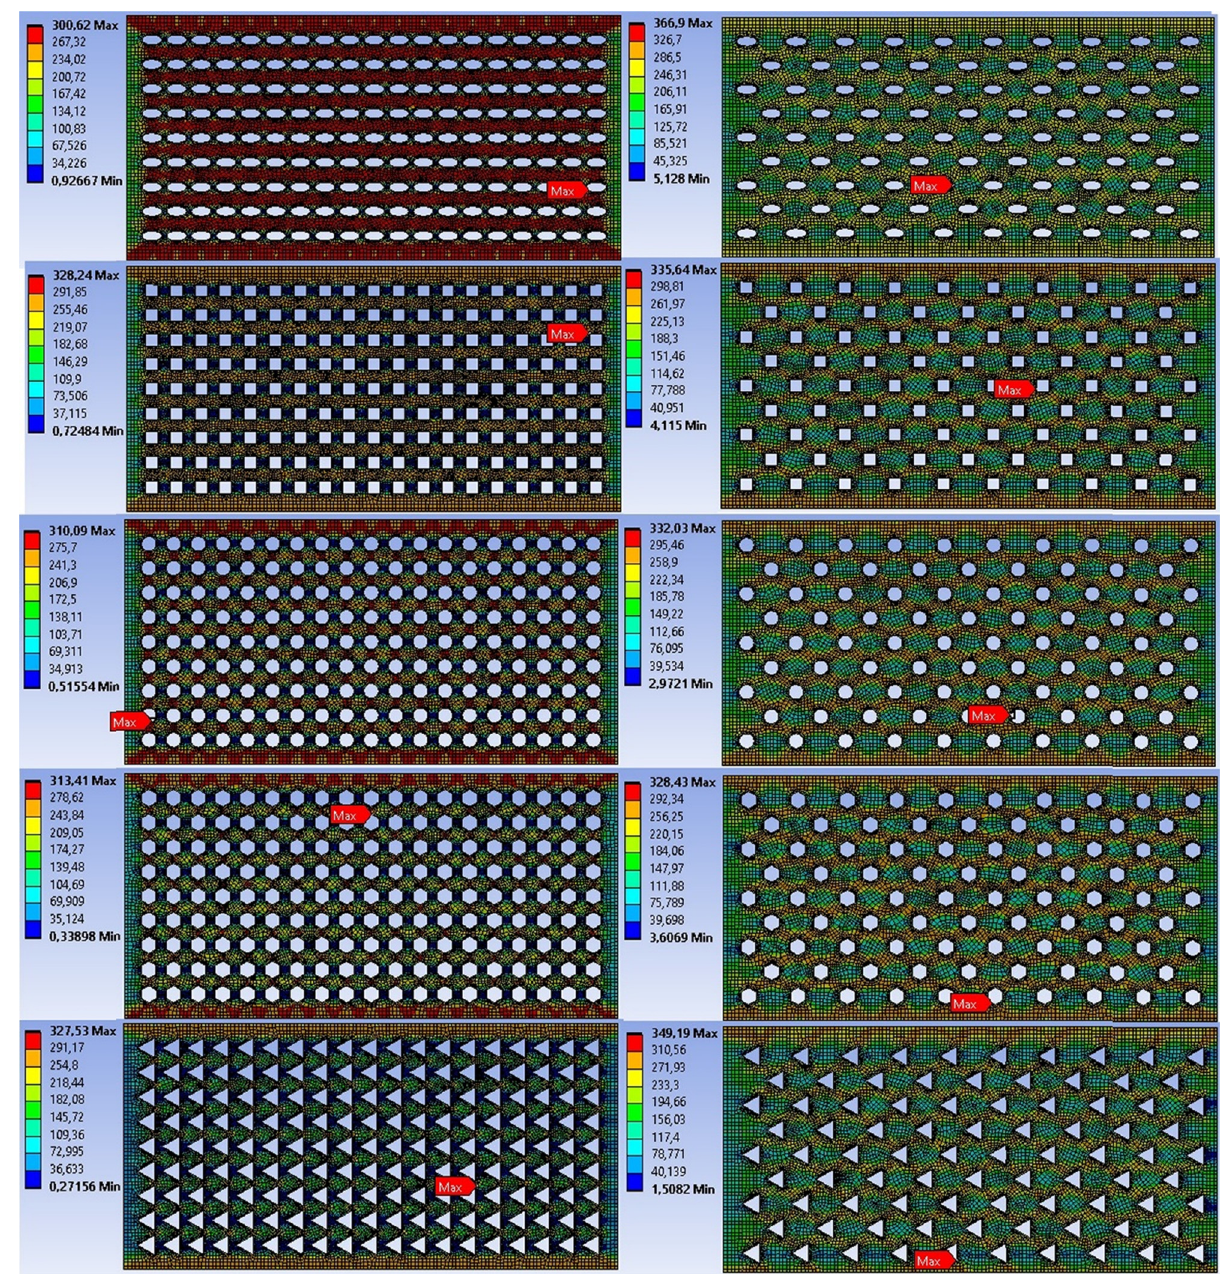
Figure 7: von Mises stress distribution of the perforated aluminium